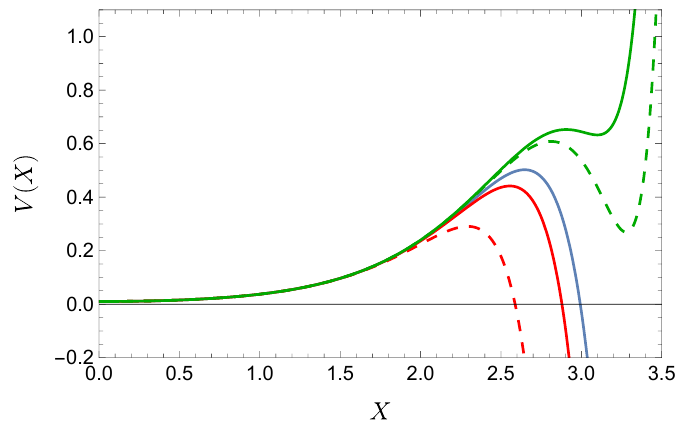
Figure 4 . Potential for X , in the presence of a scalar, with NN boundary conditions. The parameters chosen are ‘ uv = 10 , ‘ ir = 9 . 9 , ( (cid:15), α uv , α ir ) = (0.03, 0.0001, 0.0001) (red), (0.03, 0.0001, 0.0005) (red dashed), ( − 0.031, 0.0001, 0.0001) (green), ( − 0.037, 0.0001, 0.0001) (green dashed), with 12 M 3 /k = 1 . Also shown is the potential without the scalar contribution (blue), with the 5 unstable extremum. The scalar dynamics in this case can give meta-stable dS as well as move the original dS maximum.